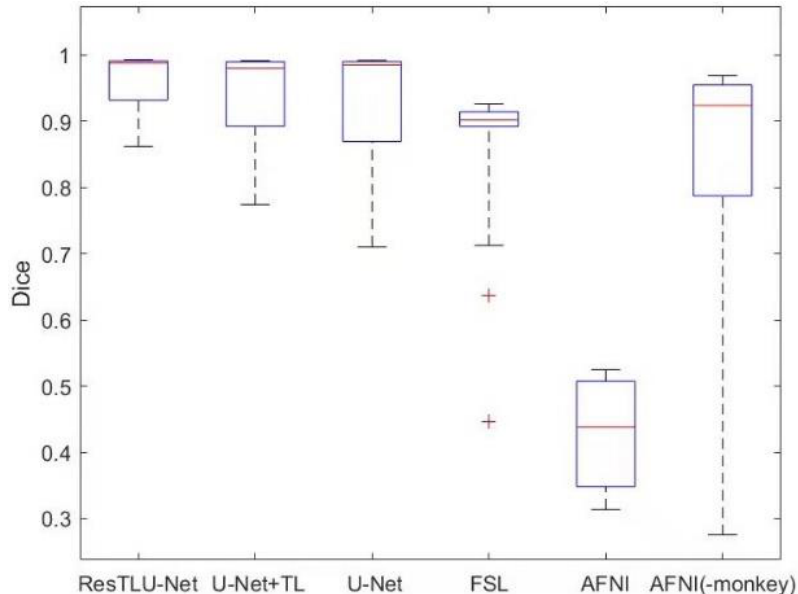
Figure 11. Performance of the ResTLU-Net models and other methods. The box plot shows the Dice coefficients in the testing datasets of Dataset II, across different brain extraction methods. “+” represents some particular discrete points far from the test result distribution.